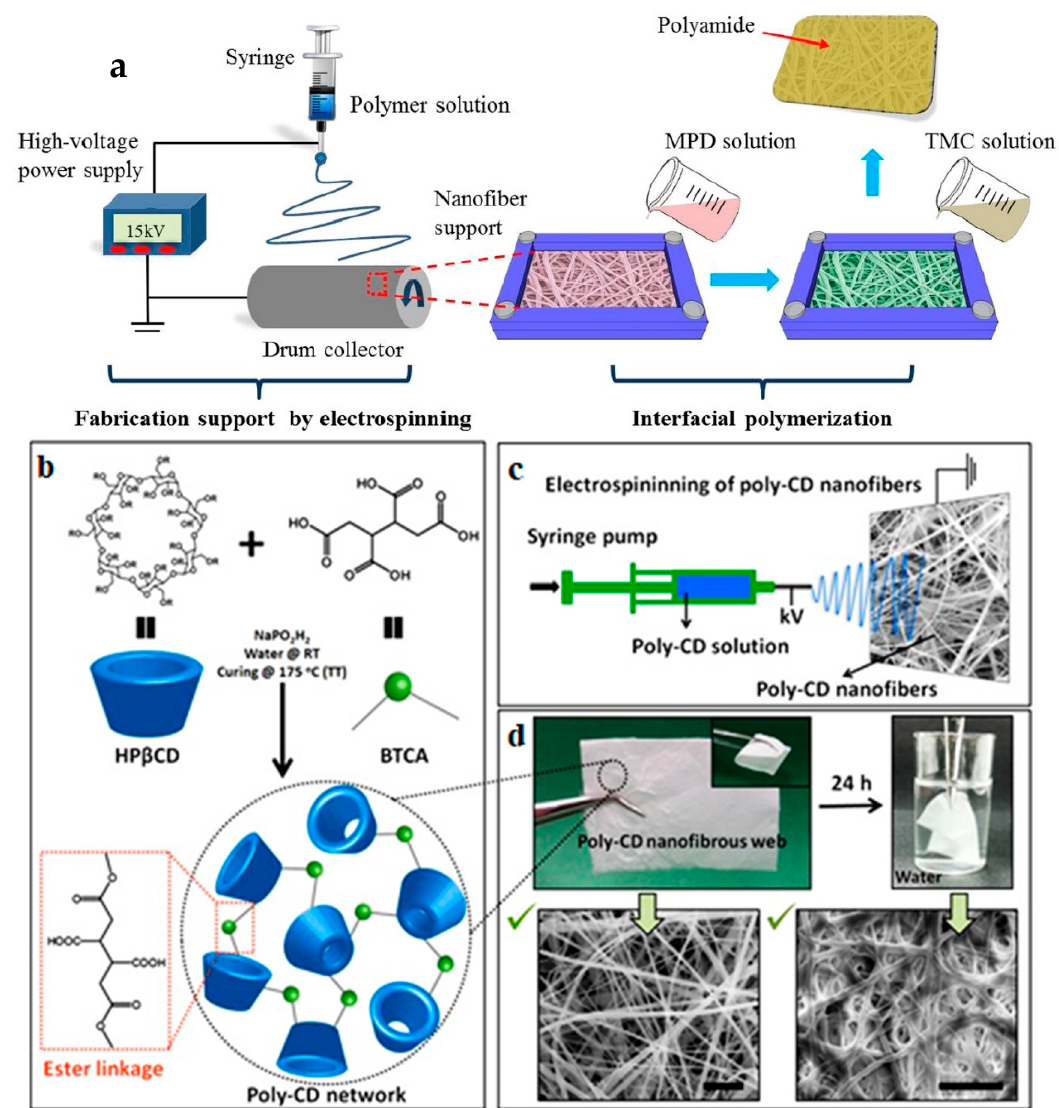
Figure 1. Schematic illustration of the fabrication ( a ) of electrospun nanofiber-supported TFC mem- brane, reproduced with permission of Elsevier [55]. ( b – d ) of the crosslinked poly-CD nanofibrous web, reproduced with permission of Springer Nature